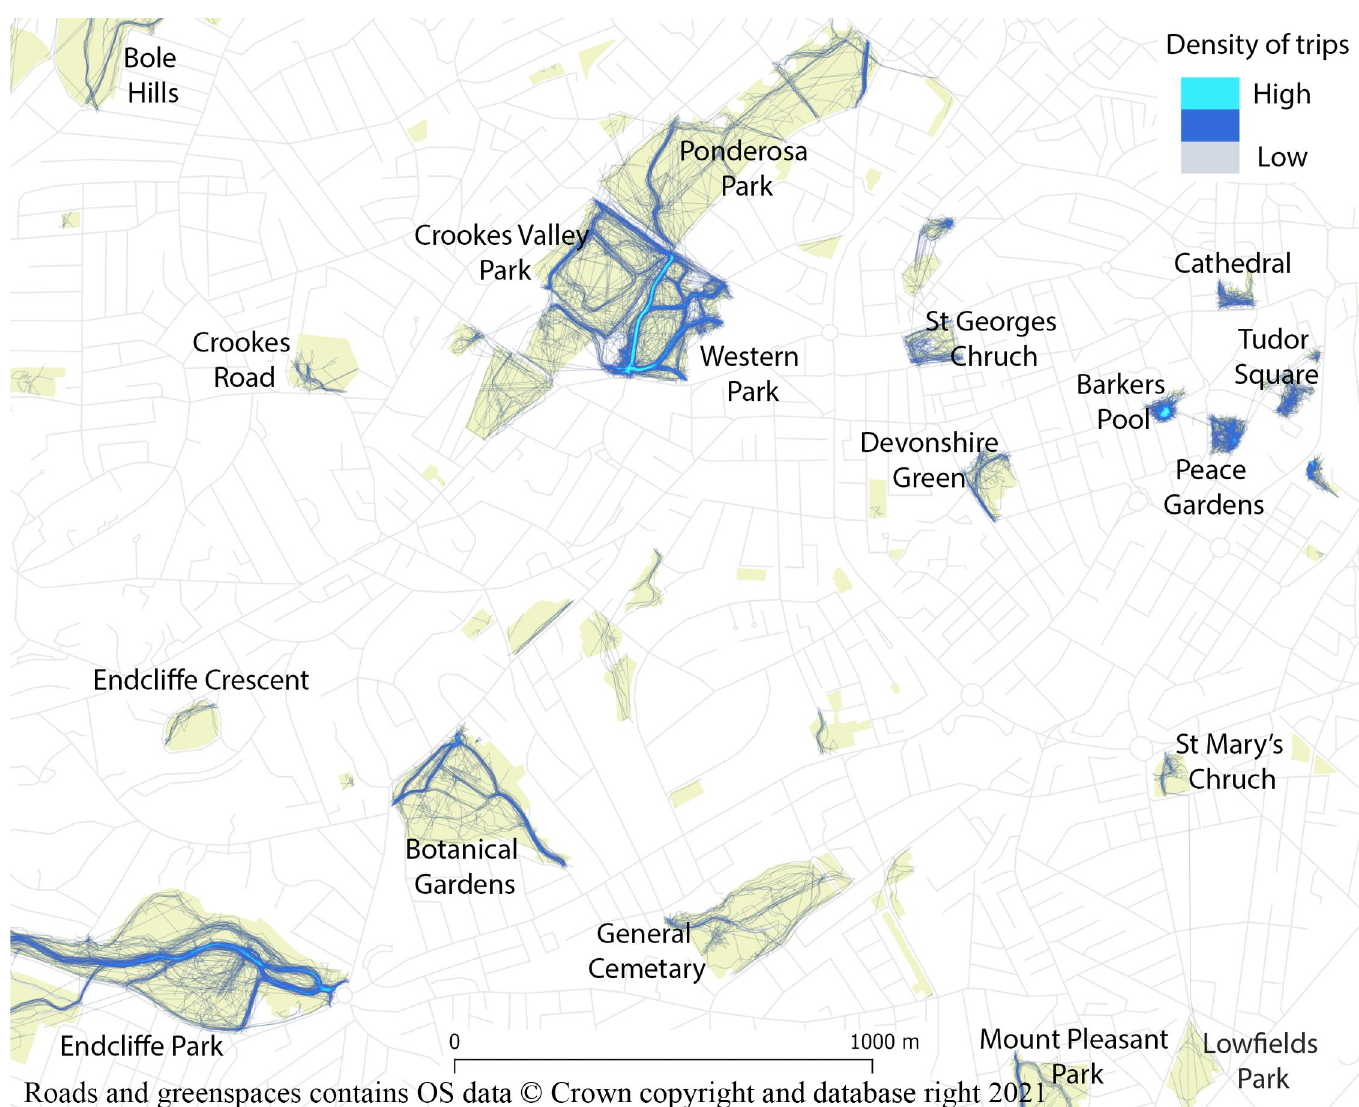
Fig 3. Mapping post-processed trips relating to visits to